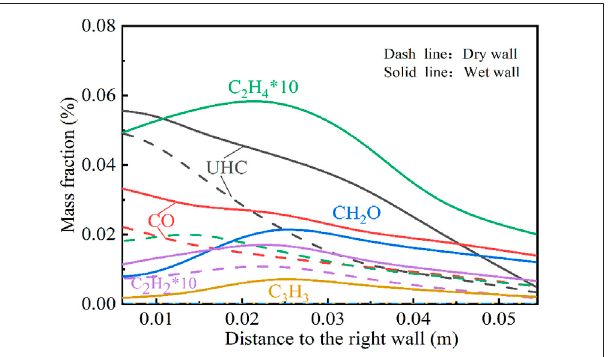
FIGURE 10 | Variation of fl ame quenching distance at different initial pressure.